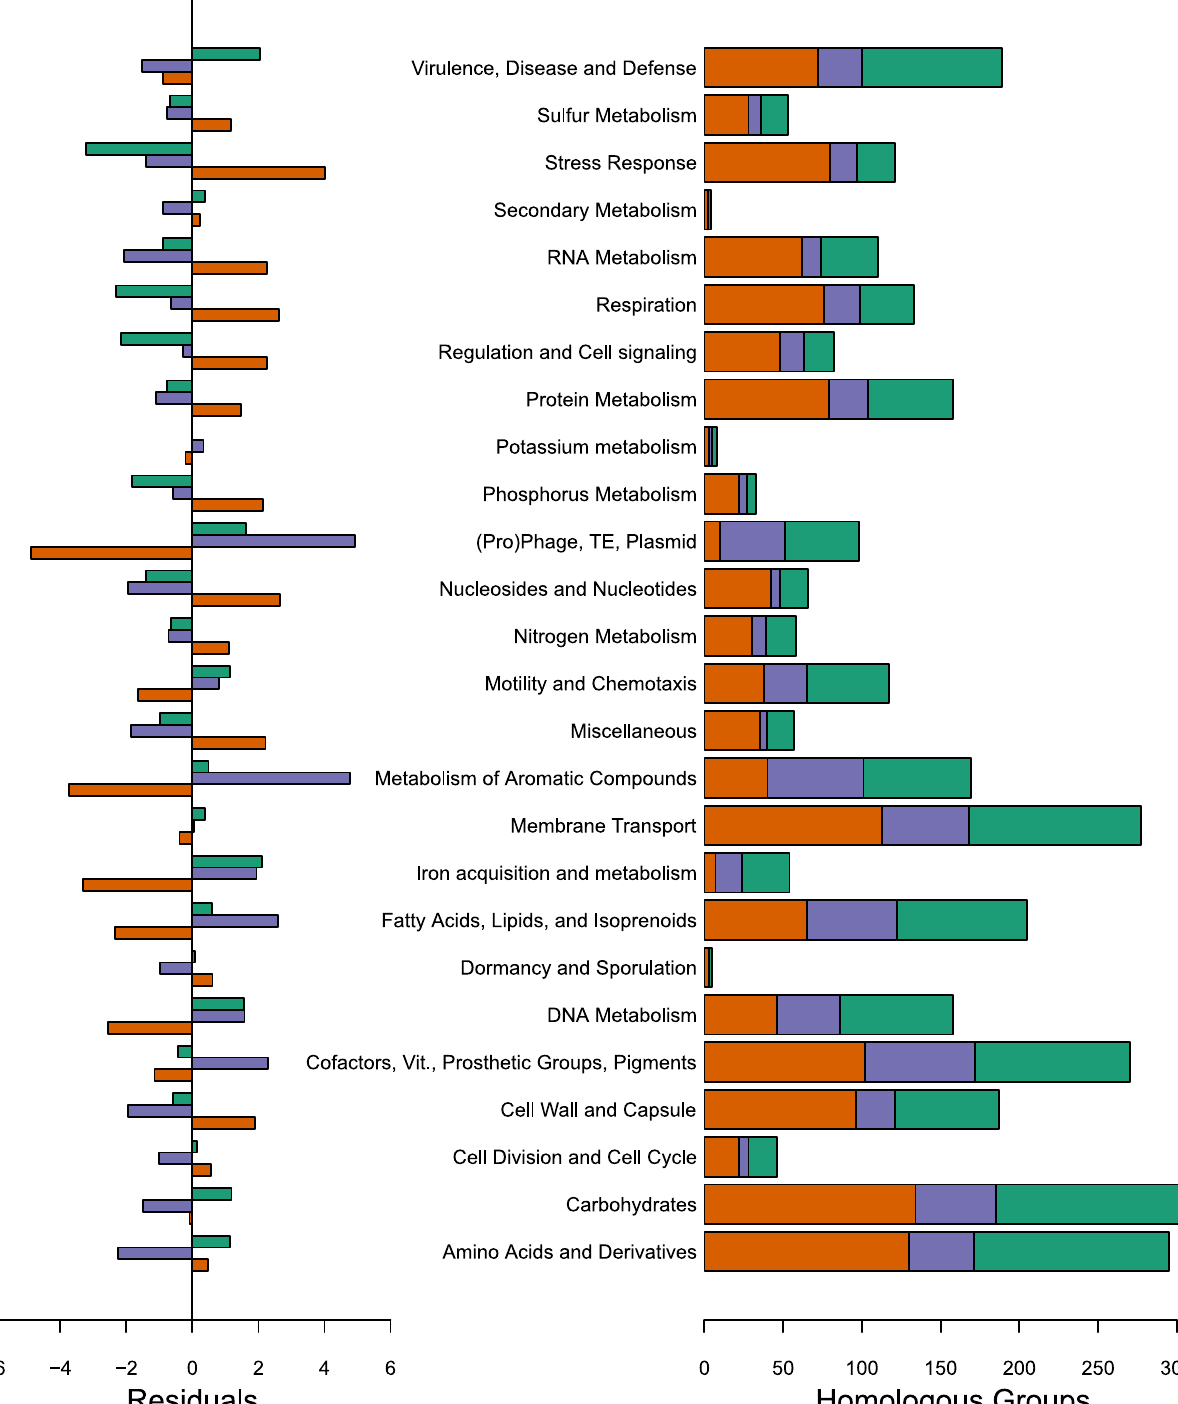
Fig 3. Distribution of gene functions. Number of core (orange), character (purple), and strain-specific (green) genes in each of the RAST functional groups (right). Proteins labeled “ hypothetical ” , “ putative ” , or without a functional category were not included. Χ 2 residuals are shown on the left (see text for details).